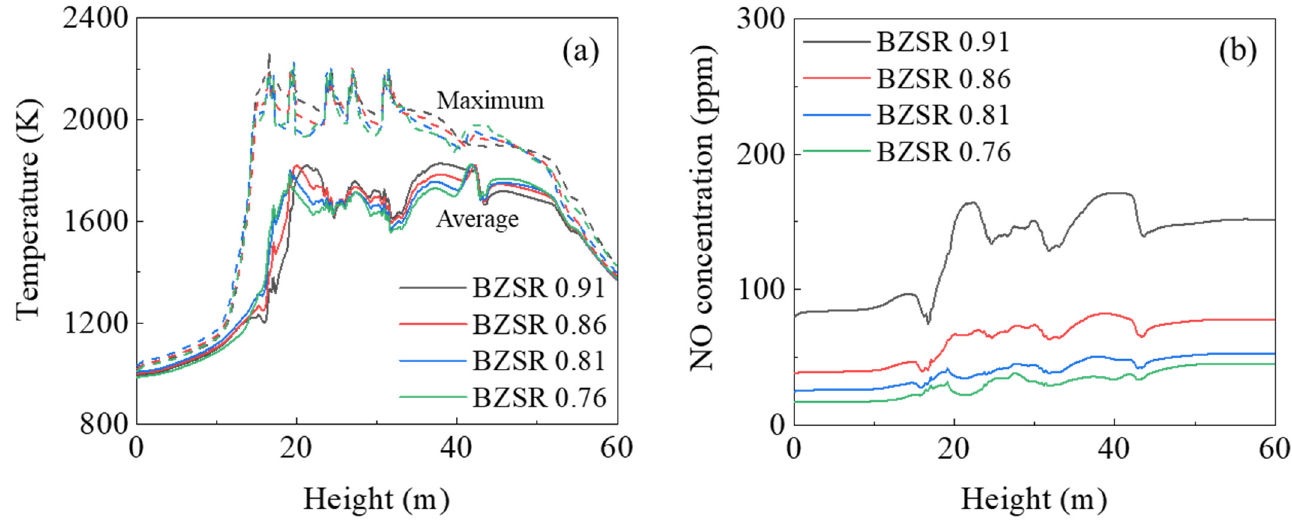
Figure 9. ( a ) Gas temperature and ( b ) NO mole fraction profiles with different burner zone stoichi- ometric ratios